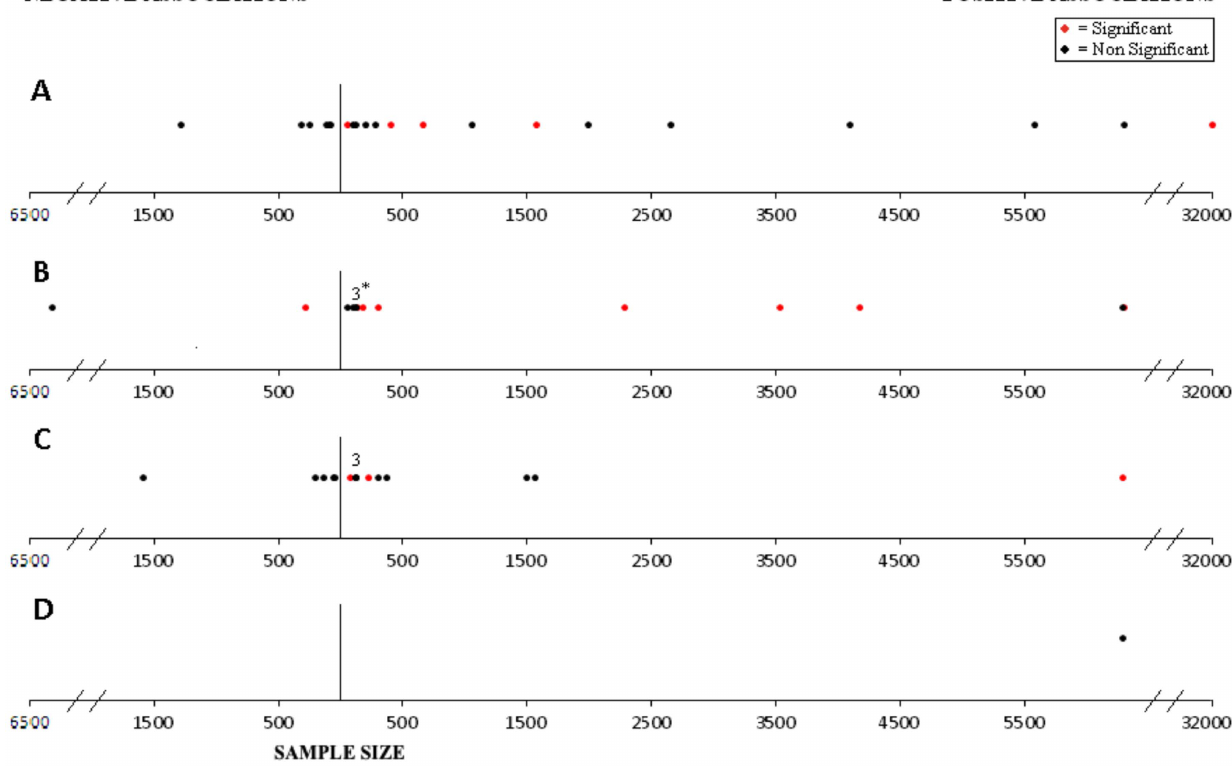
Figure 3. Associations between socioeconomic measures and event-free and overall survival in high-income countries. A. Ecologic measures B. Measures of material possession, family composition, insurance status, immigrant status, and health care accessibility. C. Measures of education and occupation. D. Measures of income. Positive=lower socioeconomic status associated with inferior outcome; Negative=lower socioeconomic status associated with superior outcome. Magnitudes of association are not plotted. Statistically significance is denoted in red. Data points with a number above represent multiple socioeconomic variables. 3* indicates 2 non-significant associations and one significant association.